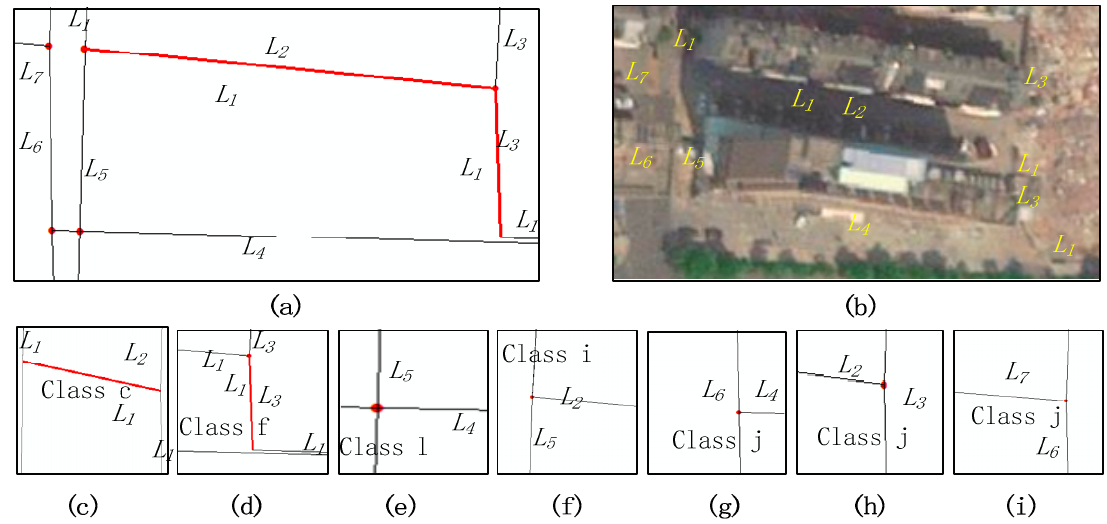
Figure 20. Examples of the intersection component types between traffic lines in the test data. ( a ) Intersection components between traffic lines; ( b ) Satellite images of the corresponding area; ( c ) The class(type) of intersection-line is h; ( d ) The class of intersection-point is l; ( e ) The class of intersection-point is j; ( f ) The class of intersection-point is l; ( g – i ) The class of intersection-point is l.